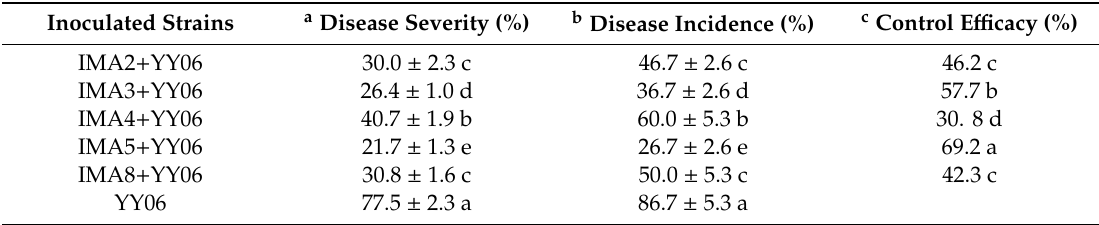
Table 3. Inhibitory e ffi cacy of five antagonistic bacterial strains against eggplant bacterium wilt 40 days after inoculation. Inoculated